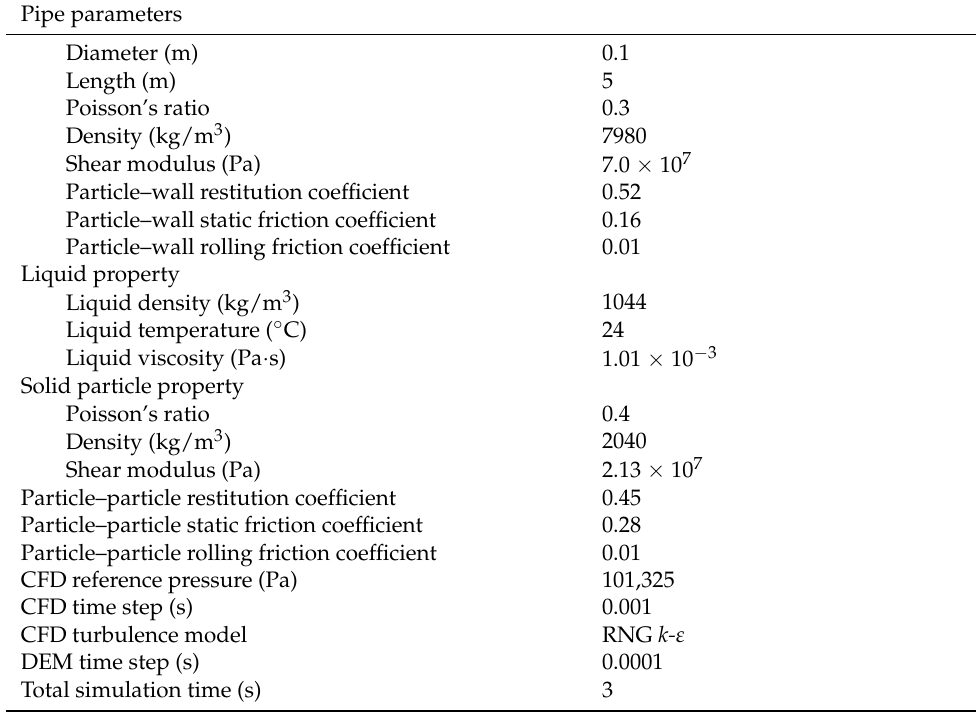
Table 1. Parameter settings for EDEM and ANSYS Fluent [27].